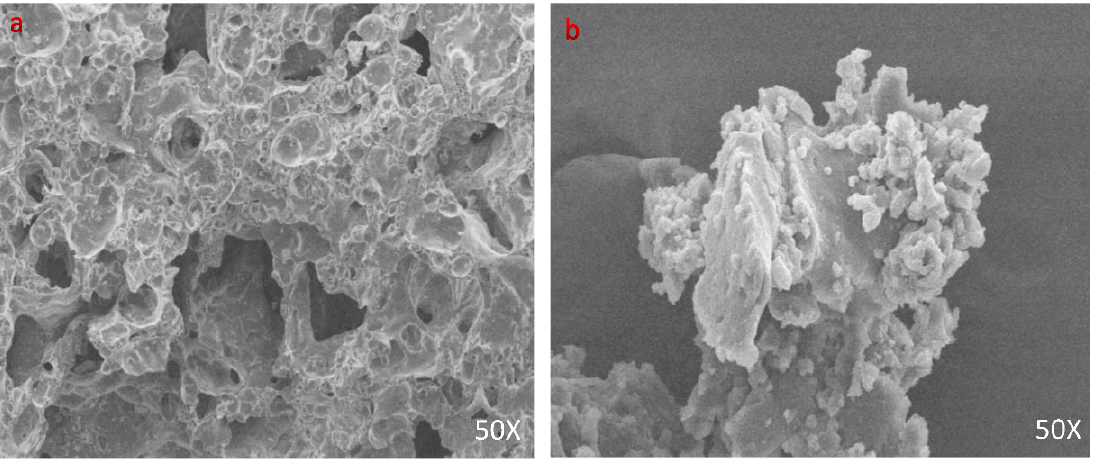
Figure 6. Diagram of water absorption and compressive strength.